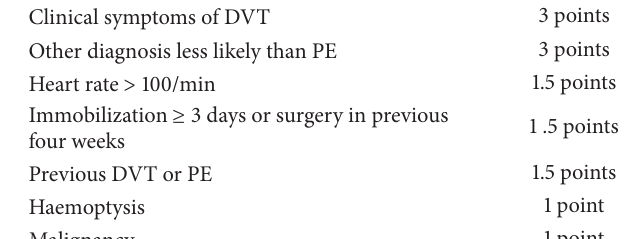
Table 1: Wells score.